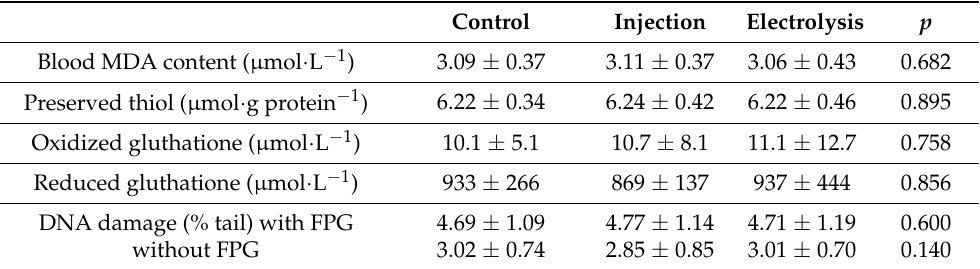
Table 4. Indices of ROS and damages in venous blood samples taken at